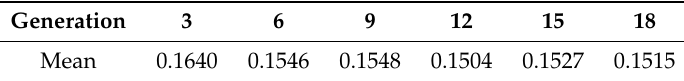
Table 13. Average Brier scores for the symbolic